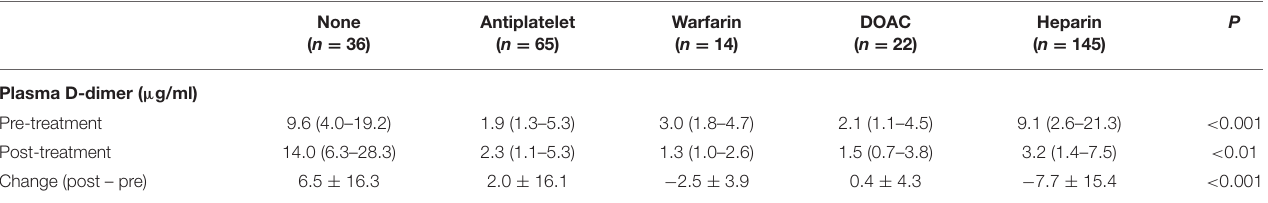
TABLE 4 | Pre- and post-treatment plasma D-dimer levels and changes in plasma D-dimer levels in each stroke treatment group.